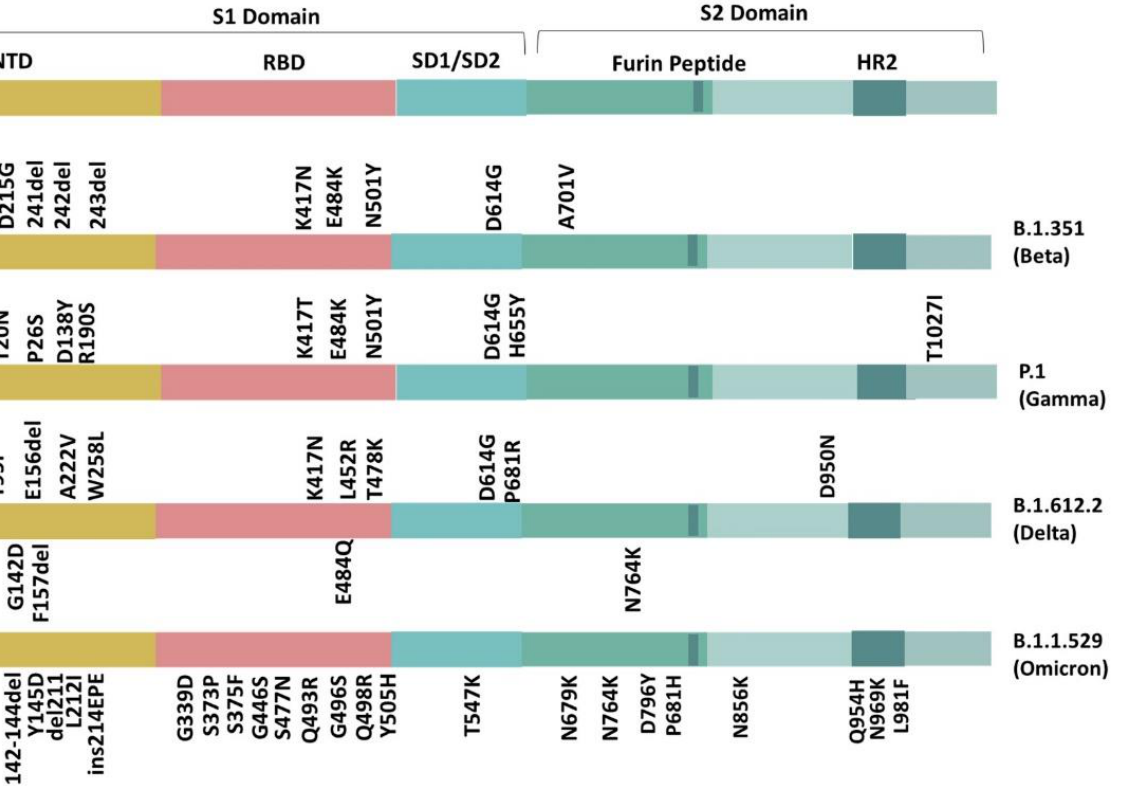
Figure 2. Mutational comparison of SARS-CoV-2 variants Beta, Gamma, Delta, and Omicron according to their regions in the S1 and S2 subunits in the spike protein.